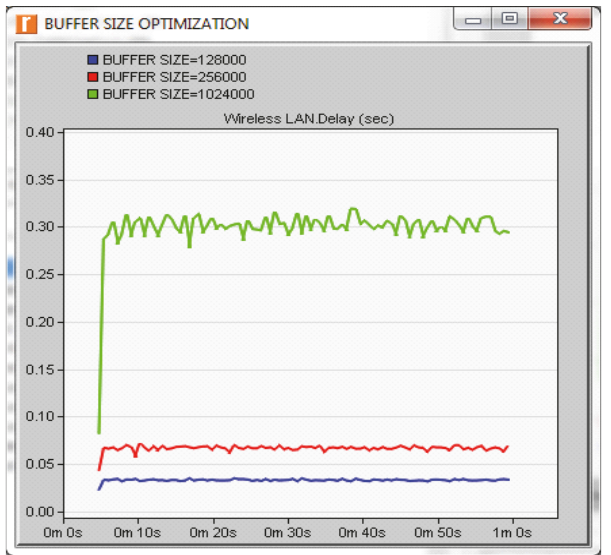
Figure 28: WLAN throughput optimization with Greenfield oper- ation.